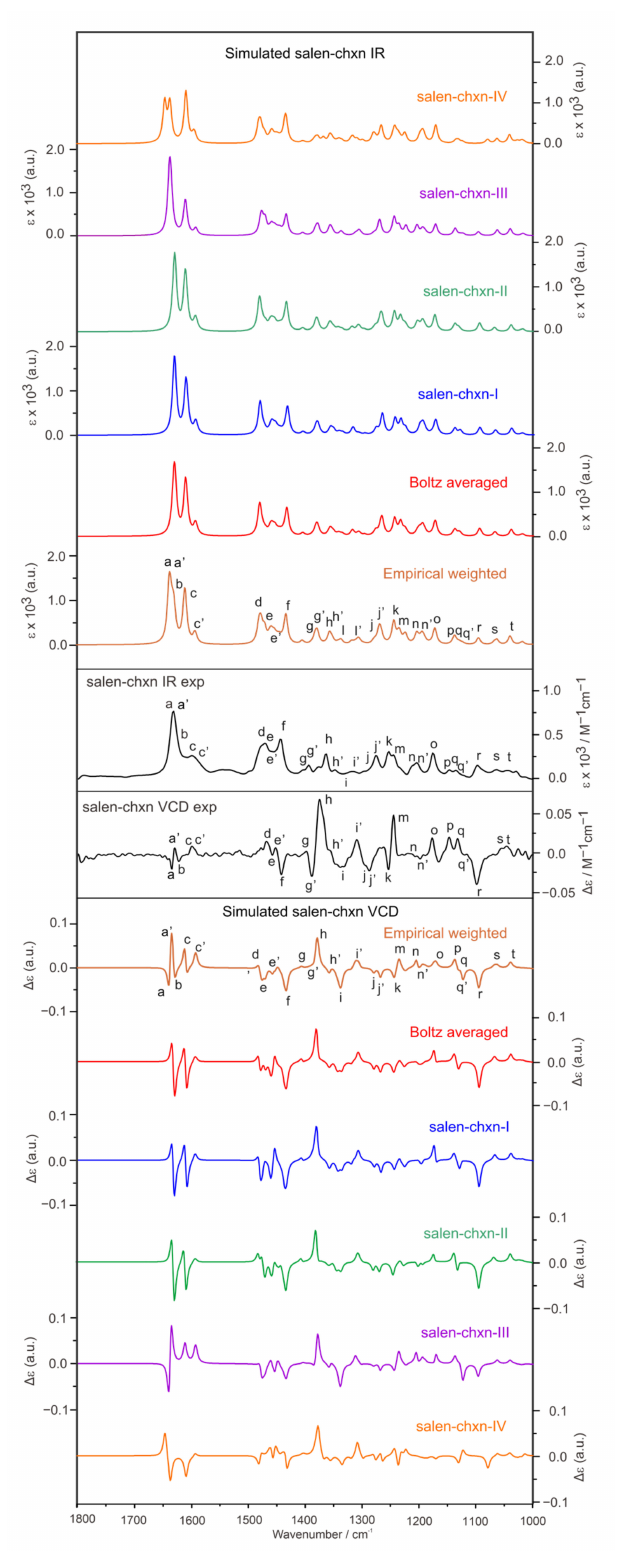
Figure 4. The simulated individual IR and VCD spectra of the four most stable salen-chxn conformers and the related Boltzmann averaged IR and VCD spectra at the B3LYP-D3BJ/def2- TZVP/PCM(CDCl 3 ) level of theory at 298 K. The experimental and empirically weighted IR and VCD spectra are also provided. The experimental units are on the right side. The main IR and VCD band features are labelled “a” to “t” to aid the